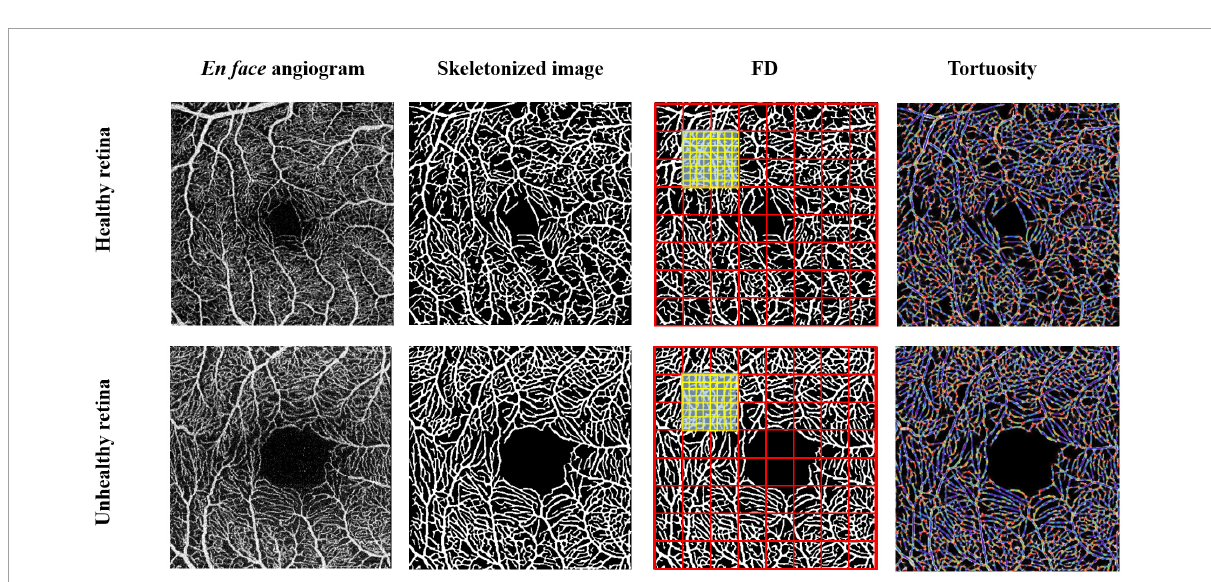
FIGURE2 Quantification of macular microvasculature of a healthy and unhealthy retina using the deep-learning algorithm. Enface images of a healthy and unhealthy retina from the swept-source optical coherence tomography angiography (SS-OCTA) were converted into a skeletonized image. Fractal dimensions using D box and microvascular tortuosity were extracted from the skeletonized image using